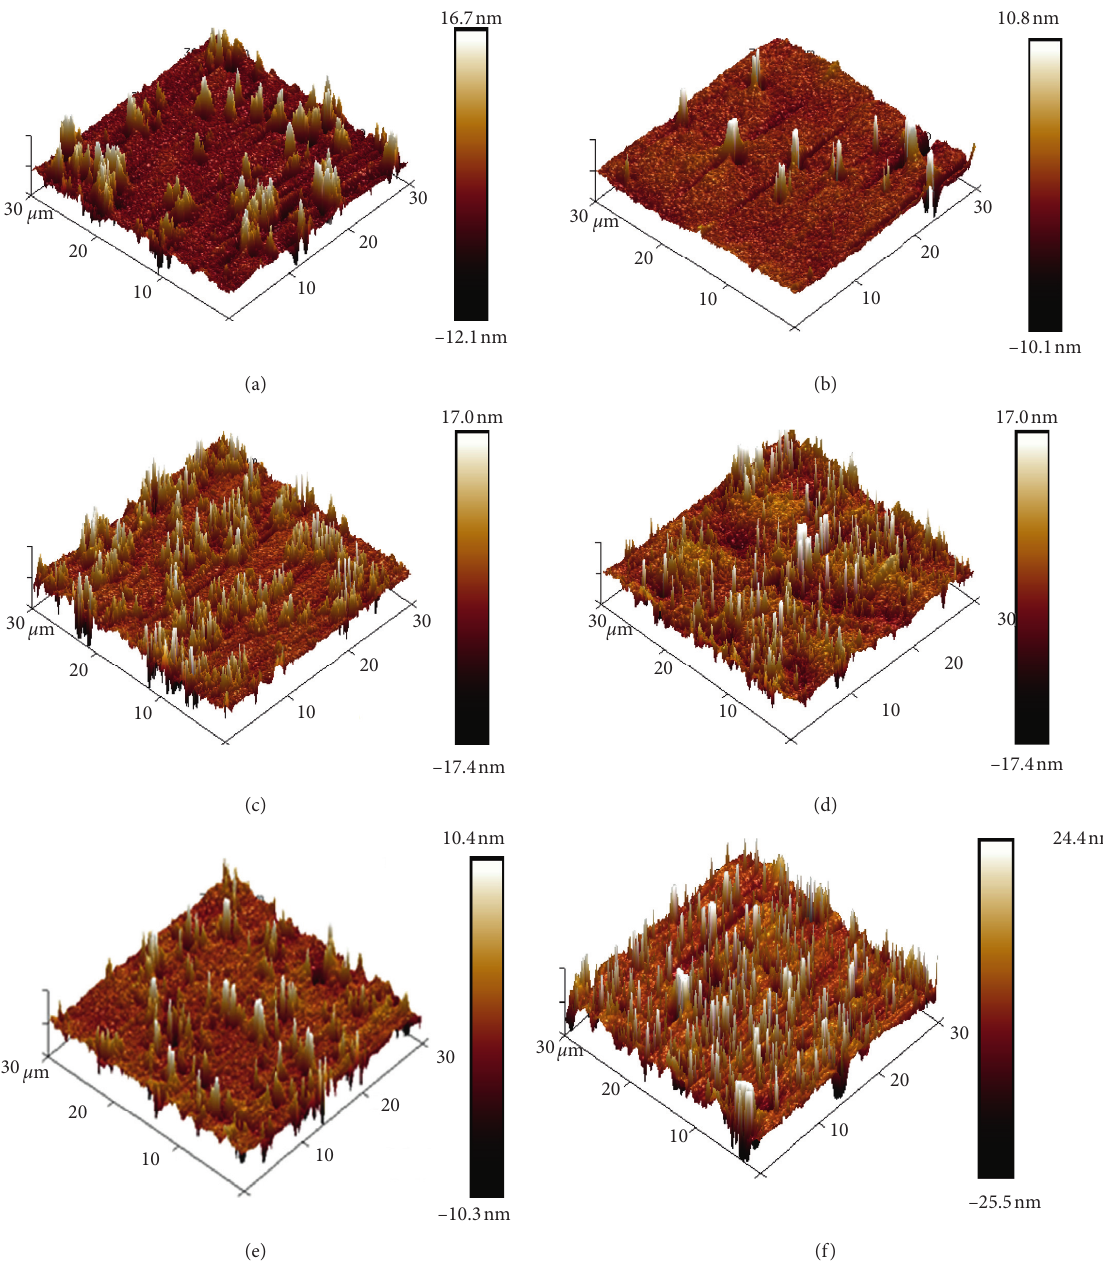
Figure 9: Three-dimensional height images of the three asphalts: (a) SBS-modified asphalt; (b) SBS-modified asphalt after immersion; (c) OMMT A-1; (d) OMMT A-1 after immersion; (e) LDH-1; (f) LDH-1 after